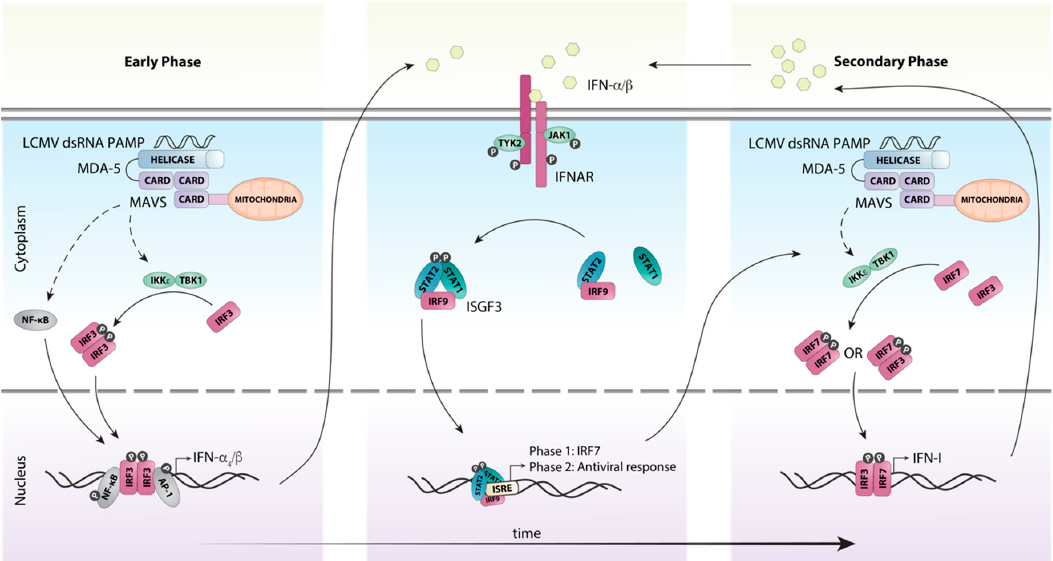
Figure 3. Schematic representation of host detection of LCMV and subsequent type I interferon induction. The production of IFN-Is in response to LCMV infection can be categorized into early and secondary phases. Upon recognition of viral dsRNA by the pattern recognition receptor MDA-5, the adaptor protein MAVS is recruited, initiating a signaling cascade involving multiple factors. This cascade results in the phosphorylation and subsequent activation of the transcription factor IRF3 by the kinases IKK ε and TBK1. Simultaneously, the transcription factors NF- κ B and AP1 are also activated and translocated to the nucleus. Together these transcription factors initiate the transcription of the initial IFN-I species IFN- β and IFN- α 4 . These early IFN-Is subsequently bind to the IFN-I receptor IFNAR in an autocrine or paracrine fashion and activate canonical IFN-I signaling through the ISGF3 complex. This results in the transcription of interferon-stimulated genes, including the transcription factor IRF7. IRF7 is then activated in a similar fashion to IRF3, resulting in the amplification of the secondary IFN-I response. Solid arrows indicate direct steps, dashed arrows indicate multiple steps/additional proteins involved.